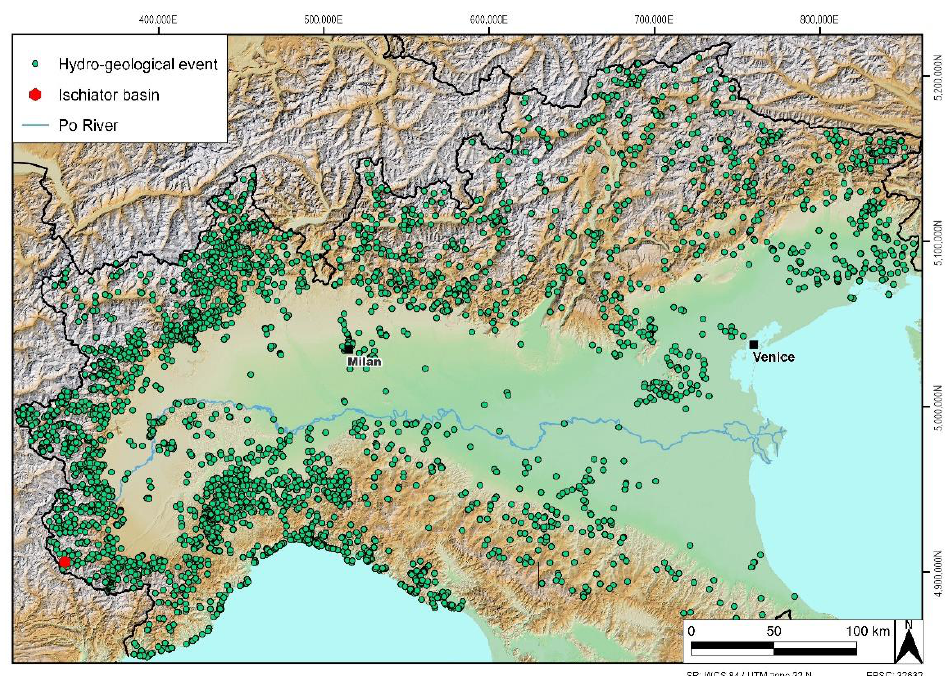
Figure 1. Distribution of the torrential processes that have produced damage, and often casualties, in the last 250 years in the Italian Alps. Historical research was conducted by the authors up to 1970, while, for subsequent events, surveys were also carried out in the affected areas.